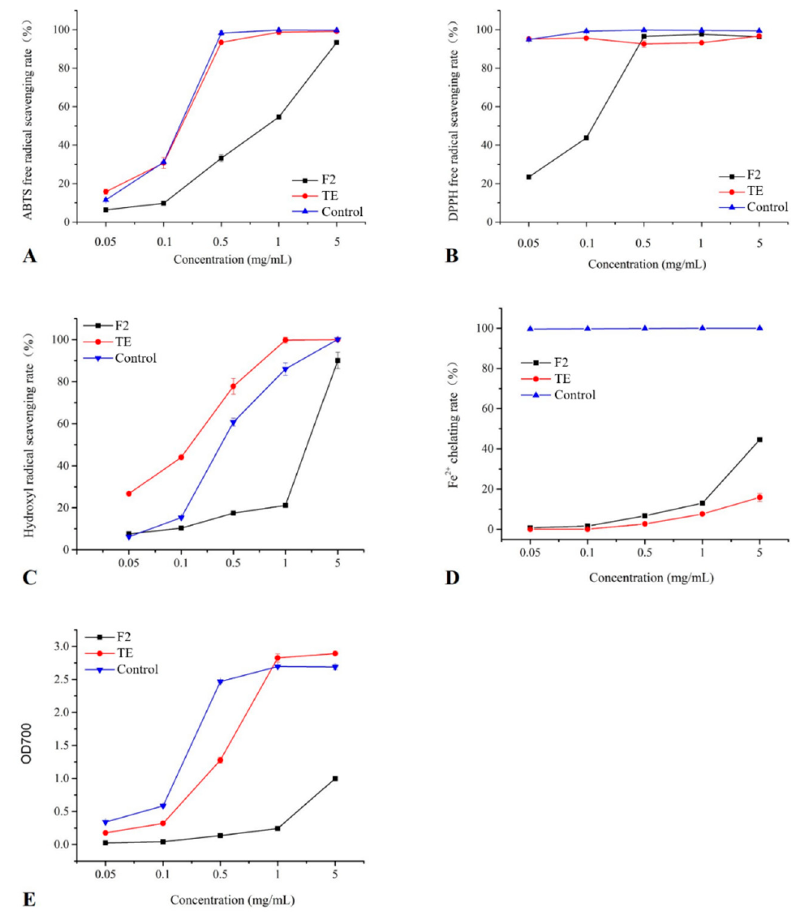
Figure 2. The antioxidant scavenging capacity of the ethanolic extract and newly identified com- pounds from the seed coat of Torreya grandis as determined by ( A ) ABTS scavenging activities, ( B ) DPPH · scavenging activities, ( C ) hydroxyl radical scavenging activities, ( D ) Fe 2+ chelating activity, and ( E ) reducing power.